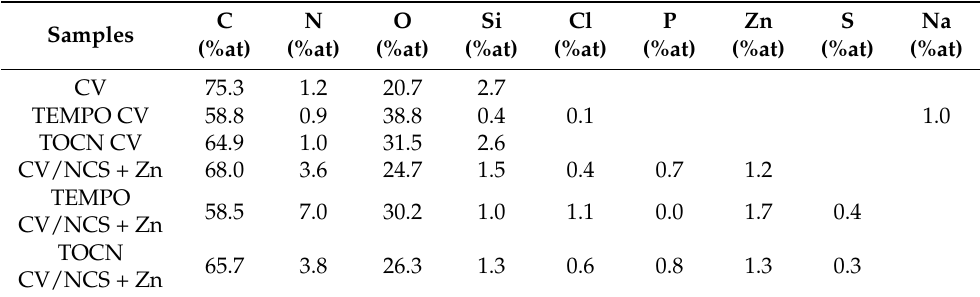
Table 2. Chemical composition of the pristine and pre-treated viscose fabrics before and after NCS + Zn functionalization determined by XPS.